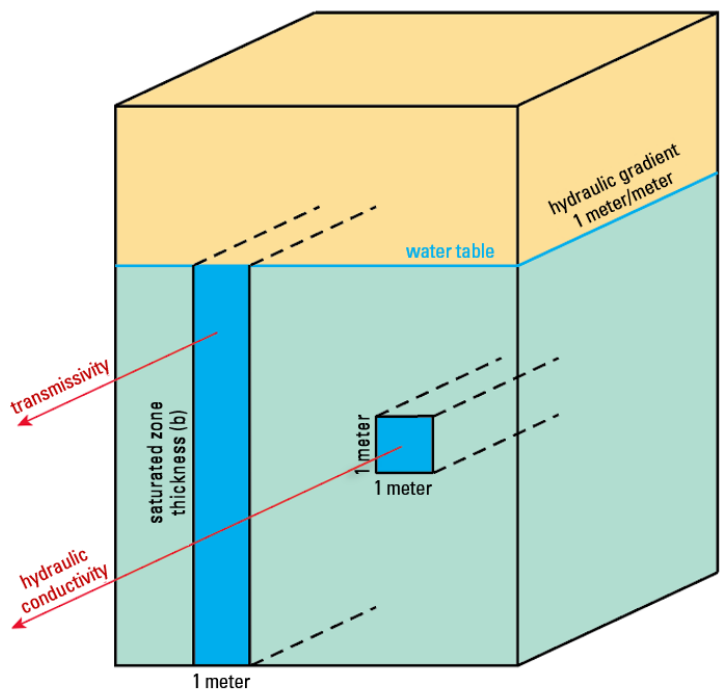
Figure 6. Schematic of transmissivity and hydraulic conductivity.